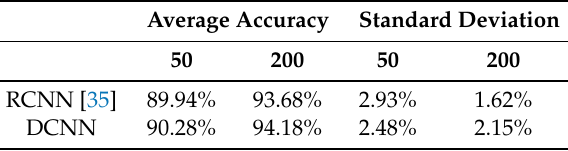
Table 10. Average accuracy scores and their standard deviation of the 10-fold cross-validation of the WISDM